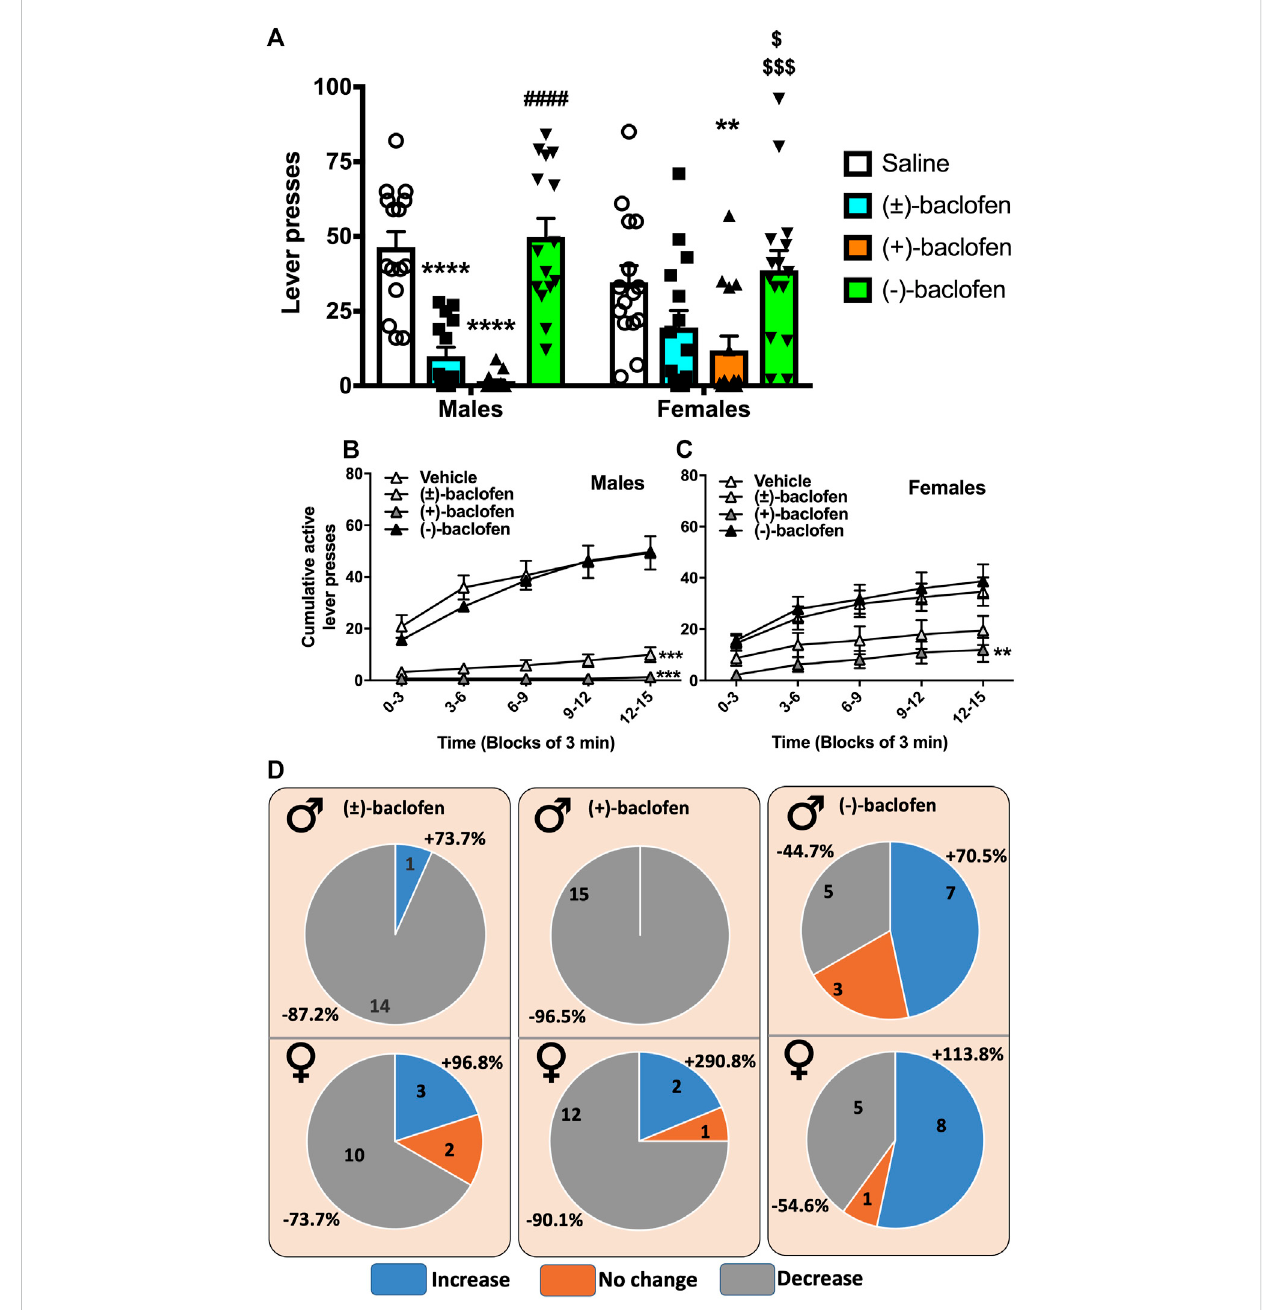
FIGURE 2 Effect of the different forms of Baclofen on alcohol operant self-administration in male and female rats. (A) The RS(±)-, the R(+)- and the S( − )- Baclofen wereadministeredi.p.atthedoseof1.5 mg/kg30 min priorto a15-minsessionofalcohol self-administration.Eachratwasitsowncontrol and received the 4 injections in random order. Results are expressed as Mean ± SEM of pure alcohol consumed in g/kg. * p < 0.05, ** p < 0.01, *** p < 0.001, **** p < 0.0001,#### p < 0.0001vs.R(+)andRS(±)-Baclofen,and$$$$ p < 0.0001vs.RS(±)-Baclofen. (B) Cumulativeleverpressesobservedafter theinjectionof thedifferentforms of Baclofen in male rats. Resultsare expressedas Mean ± SEM of thecumulativepresses in3-min bins over the15 min session. *** p < 0.001 vs. Vehicle. (C) Cumulative lever presses observed after the injection of the different forms of Baclofen in female rats. Results are expressed as Mean ± SEM of the cumulative presses in 3-min bins over the 15 min session. ** p < 0.01 vs. Vehicle. (D) Distribution of animal responses regardingsex(MformalesandFforfemalesontheleftcorner)andthetreatments.Numbersinsidethecircleindicatethenumberofanimalsoverthetotal of15rats.Percentagesoutsidethecircleexpresstheamplitudeofthevariation inalcoholself-administration ascomparedto thevehicletreatment. Light greyrepresentsadecreaseinalcoholself-administration.Themildgreyrepresentsnochange(between( − 10and+10%)ascomparedtovehicle.Thedark grey represents an increase in alcohol self-administration as compared to vehicle. The results depicted in each of these 4 panels were provided by the same cohort of rats, 15 males and 15